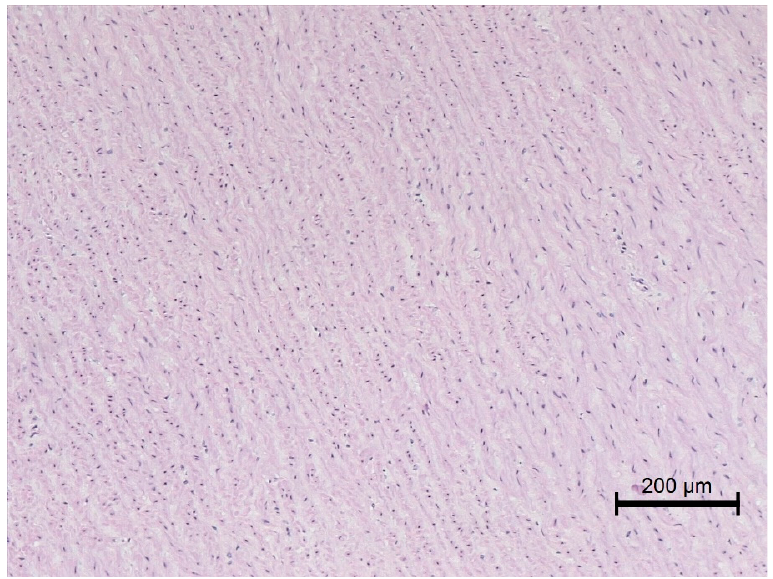
Figure 6. Microscopic image of the aorta specimen from a lean horse. Normal aortic wall; HE staining; 100 × .